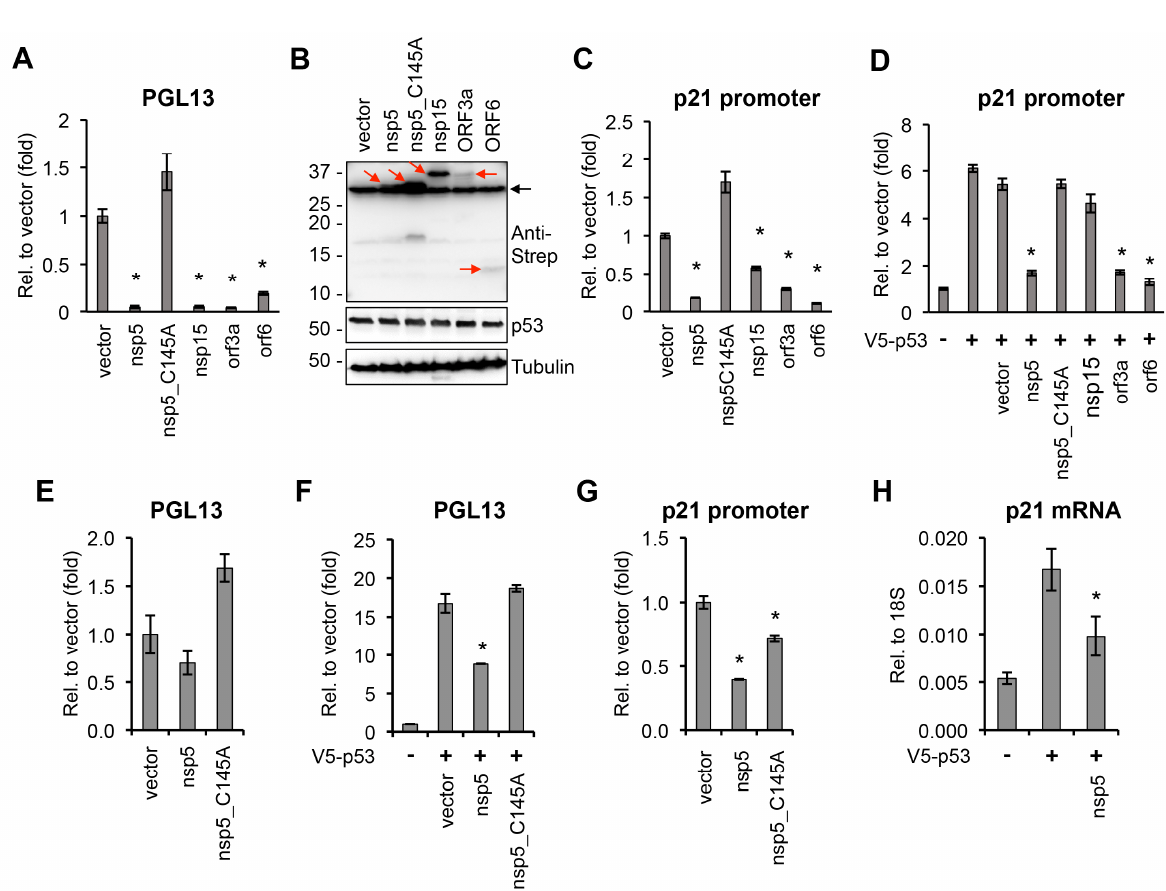
Figure 2. Effect of SARS-CoV-2 proteins on p53-regulated promoters. ( A ) PG13-Luc reporter plasmid, which includes p53 binding sites, was co-transfected with vectors expressing the indicated viral proteins into 293T cells. Luciferase activity was measured 48 h after transfection and is shown relative to the luciferase activity in the vector-transfected sample. ( B ) Immunoblot analysis of the expression of 2xStrep-tagged viral proteins and p53 in 293T cells. Red arrows point at the coronavirus proteins. Black arrow indicates non-specific band. ( C ) p21 promoter luciferase plasmid and SARS-CoV-2 factors were co-transfected into 293T cells and the luciferase activity was captured at 48 h post-transfection. ( D ) The same luciferase assay as described in panel C was performed, except the cells were also transfected with a V5-p53 expression plasmid. ( E ) The luciferase assay shown in panel A was repeated in HEK293 cells. ( F ) PG13-Luc reporter plasmid was co-transfected with nsp5 or its mutant into HEK293 cells, and luciferase activity was measured 48 h after transfection and is shown relative to the luciferase activity in the vector-transfected sample. ( G ) p21 promoter luciferase plasmid and nsp5 or its mutant were co-transfected into HEK293 cells, and the relative luciferase activity was measured at 48 h post-transfection. ( H ) RT-qPCR analysis of p21 gene expression in vector-, V5-p53-, and V5-p53/nsp5-2xStrep-transfected HEK293 cells. t test was performed between vector- and SARS-CoV-2 ORF-transfected samples (* p < 0.05).